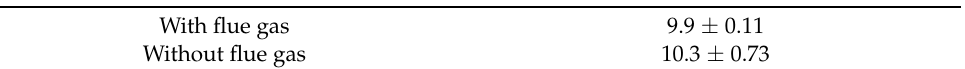
Table 7. Lipid content (%, average ± SD, n = 5) of the diatom cultivated with and without factory flue gas.